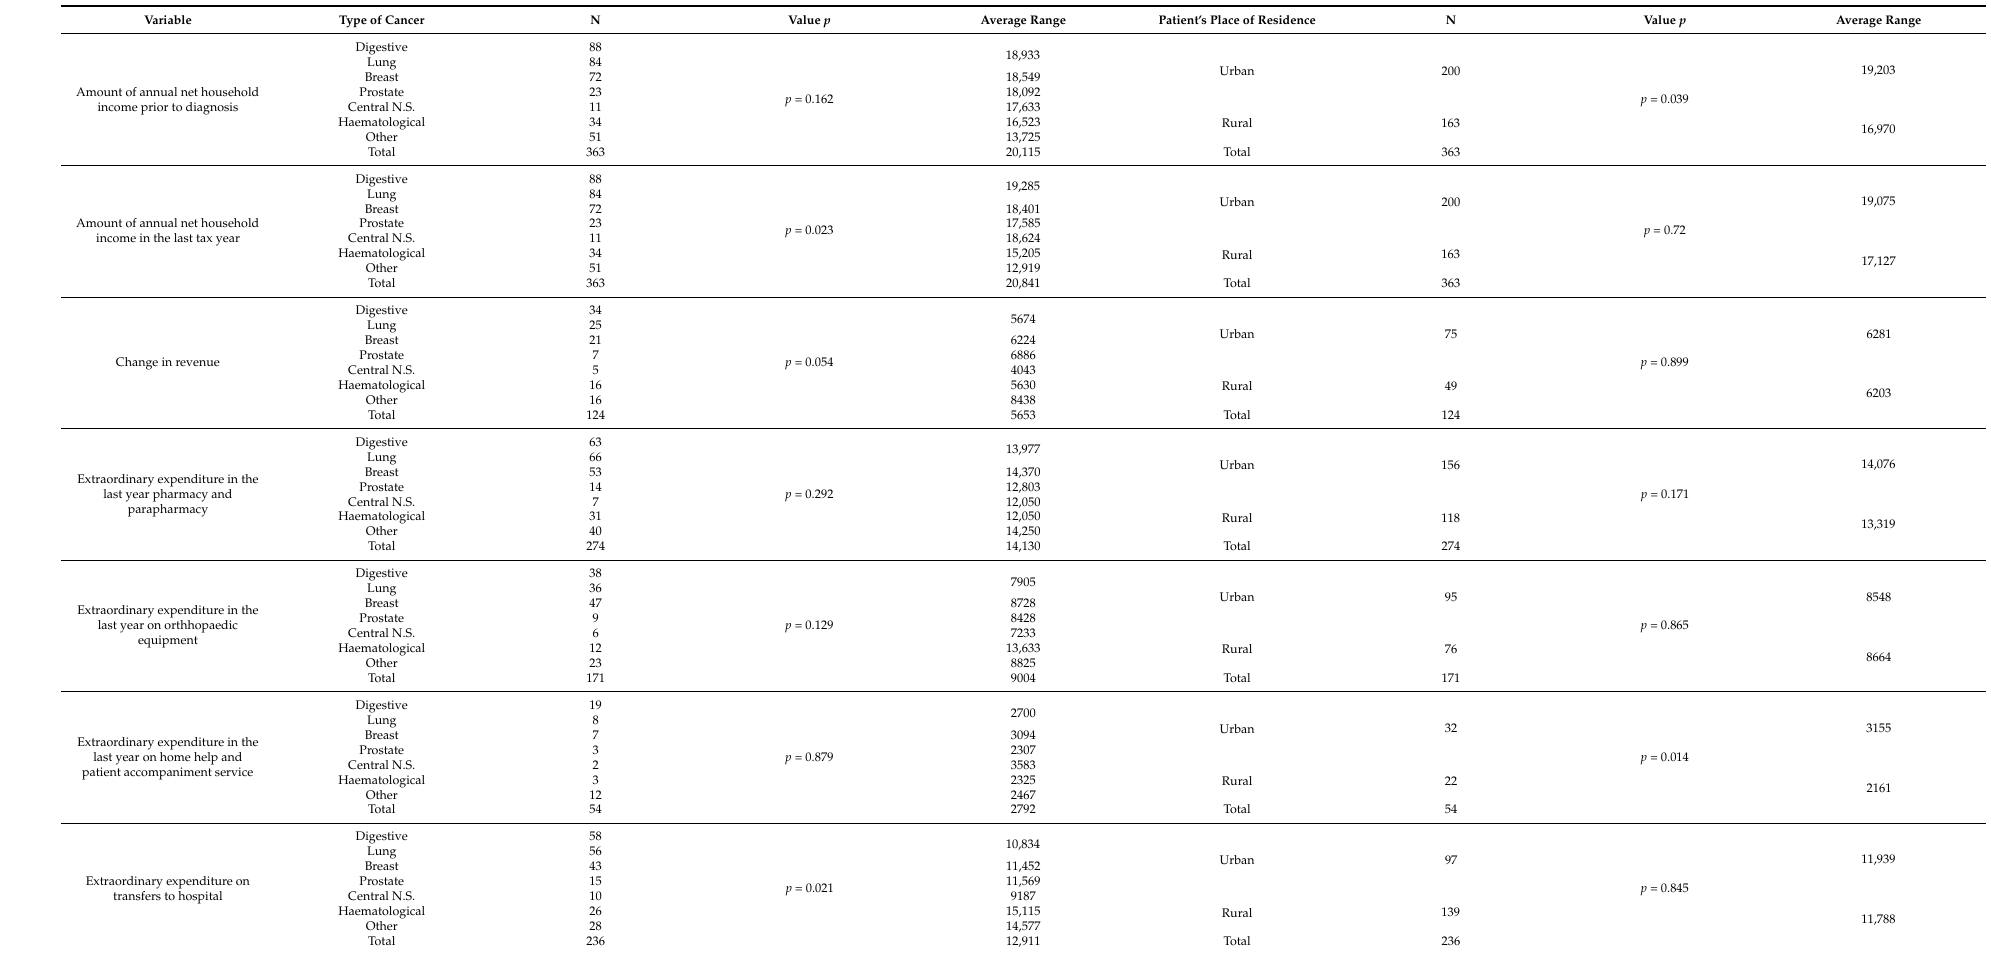
Table 3. Contrast statistics. Grouping variable: type of cancer and patient’s place of